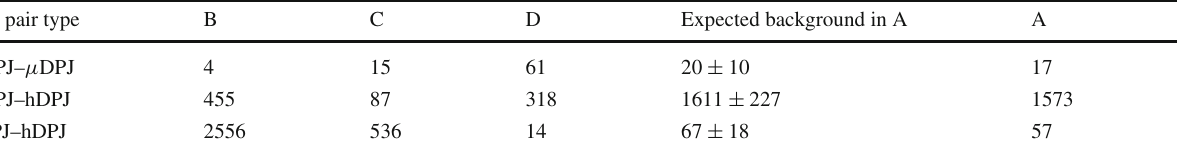
Table 3 Event count in each of the four regions of the ABCD plane in the validation regions and expected number of background events in region A. Only statistical uncertainties are shown. The expected contri-